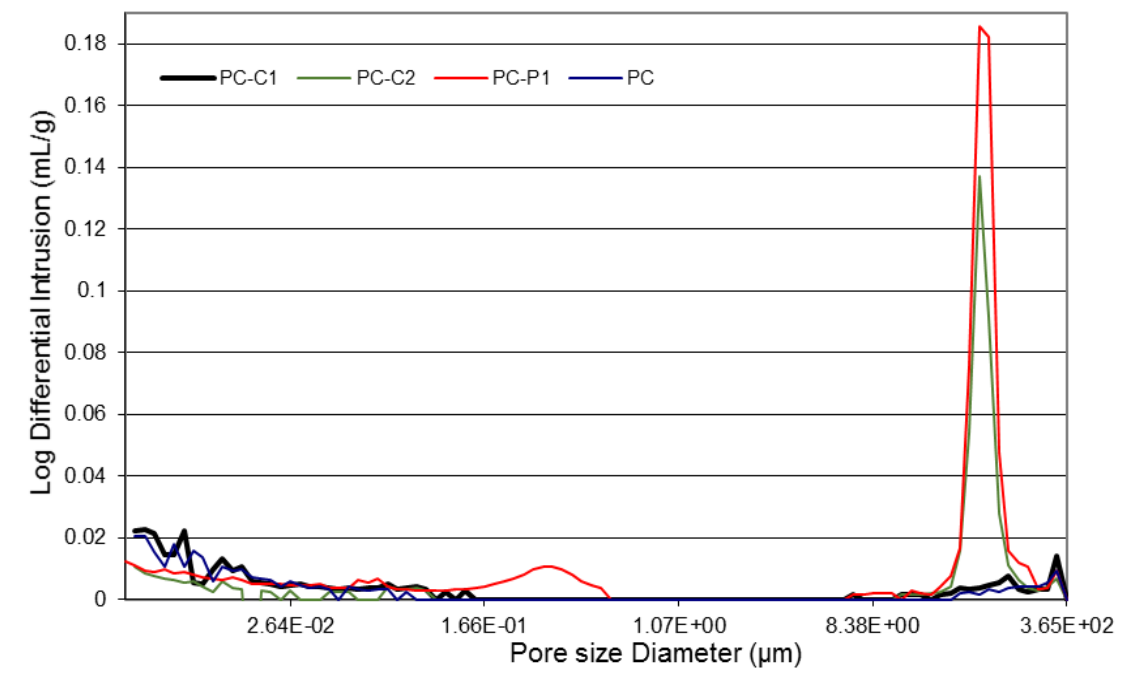
Figure 6. Pores size distribution for different PC mixes.